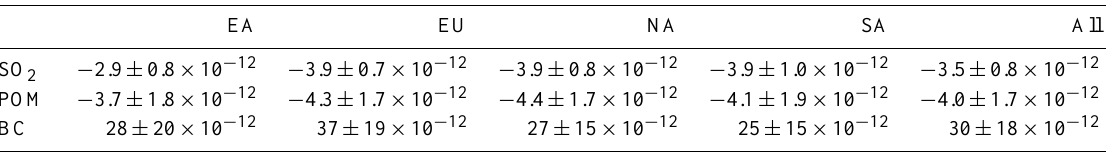
Table 1. Absolute global warming potentials (AGWPs) for emissions of SO 2 , POM and BC from the 4 HTAP continents, based on Table 6 of Yu et al. (2013). Units are Wm − 2 yrkg − 1 .The AGWPs for aerosols are approximately independent of time horizon. Note these values exclude the effects of aerosol cloud interactions and the effect of BC deposition on snow albedo. EA EU NA SA All SO 2 − 2.9 ± 0.8 × 10 −